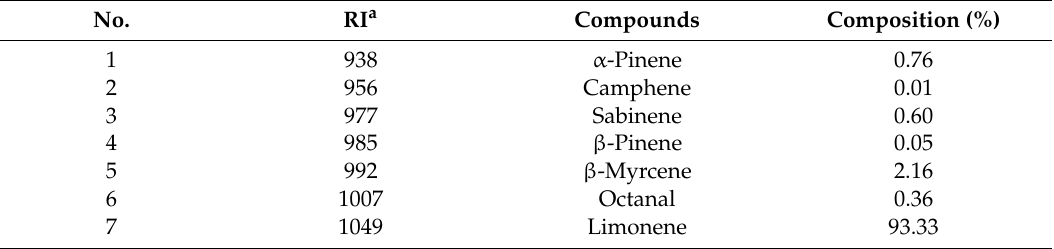
Table 1. Chemical composition of grapefruit light phase essential oil (LPEO)by GC-MS.